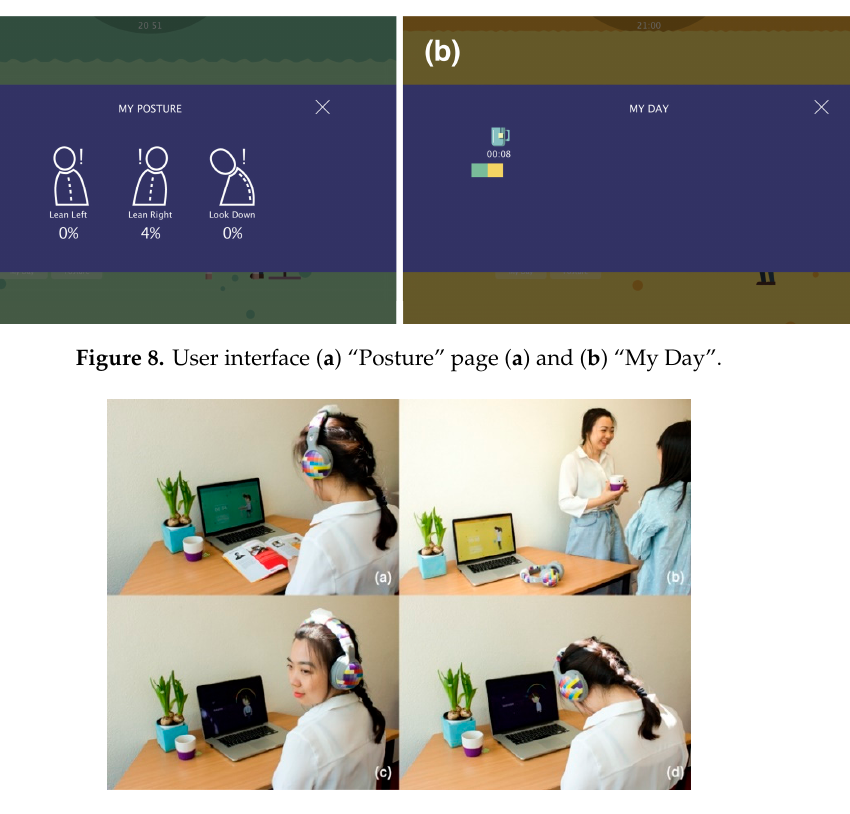
Figure 9. Modes of Neckio use ( a ) tracking mode during work; ( b ) rest; ( c ) exercise: rotation; ( d ) exercise: extension and flexion.